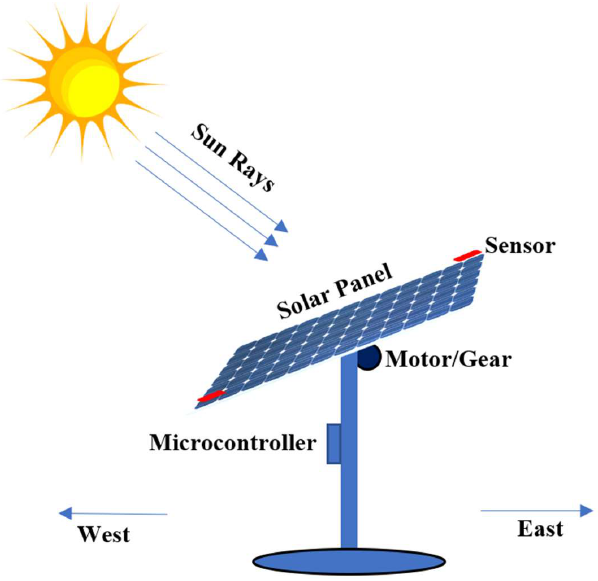
Figure 6. Active Solar Tracking